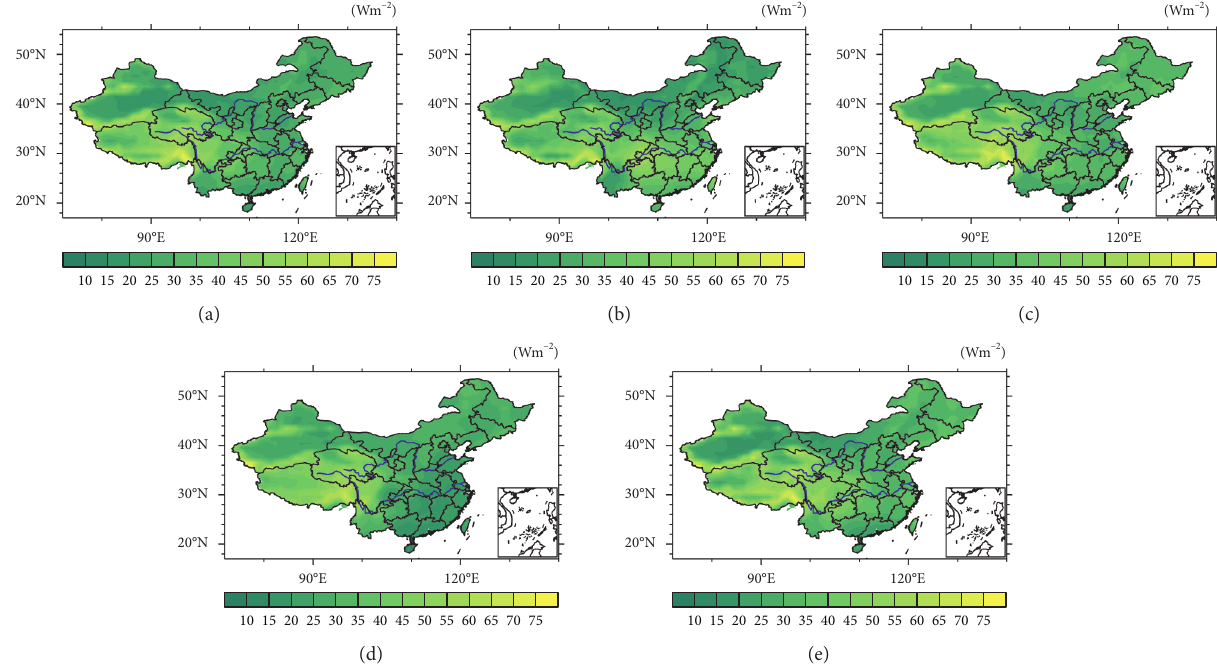
Figure 9: The difference of the DLR (Wm − 2 ) in China between the all-sky conditions and clear-sky conditions during 2001–2016: (a) annual, (b) spring, (c) summer, (d) autumn, and (e)